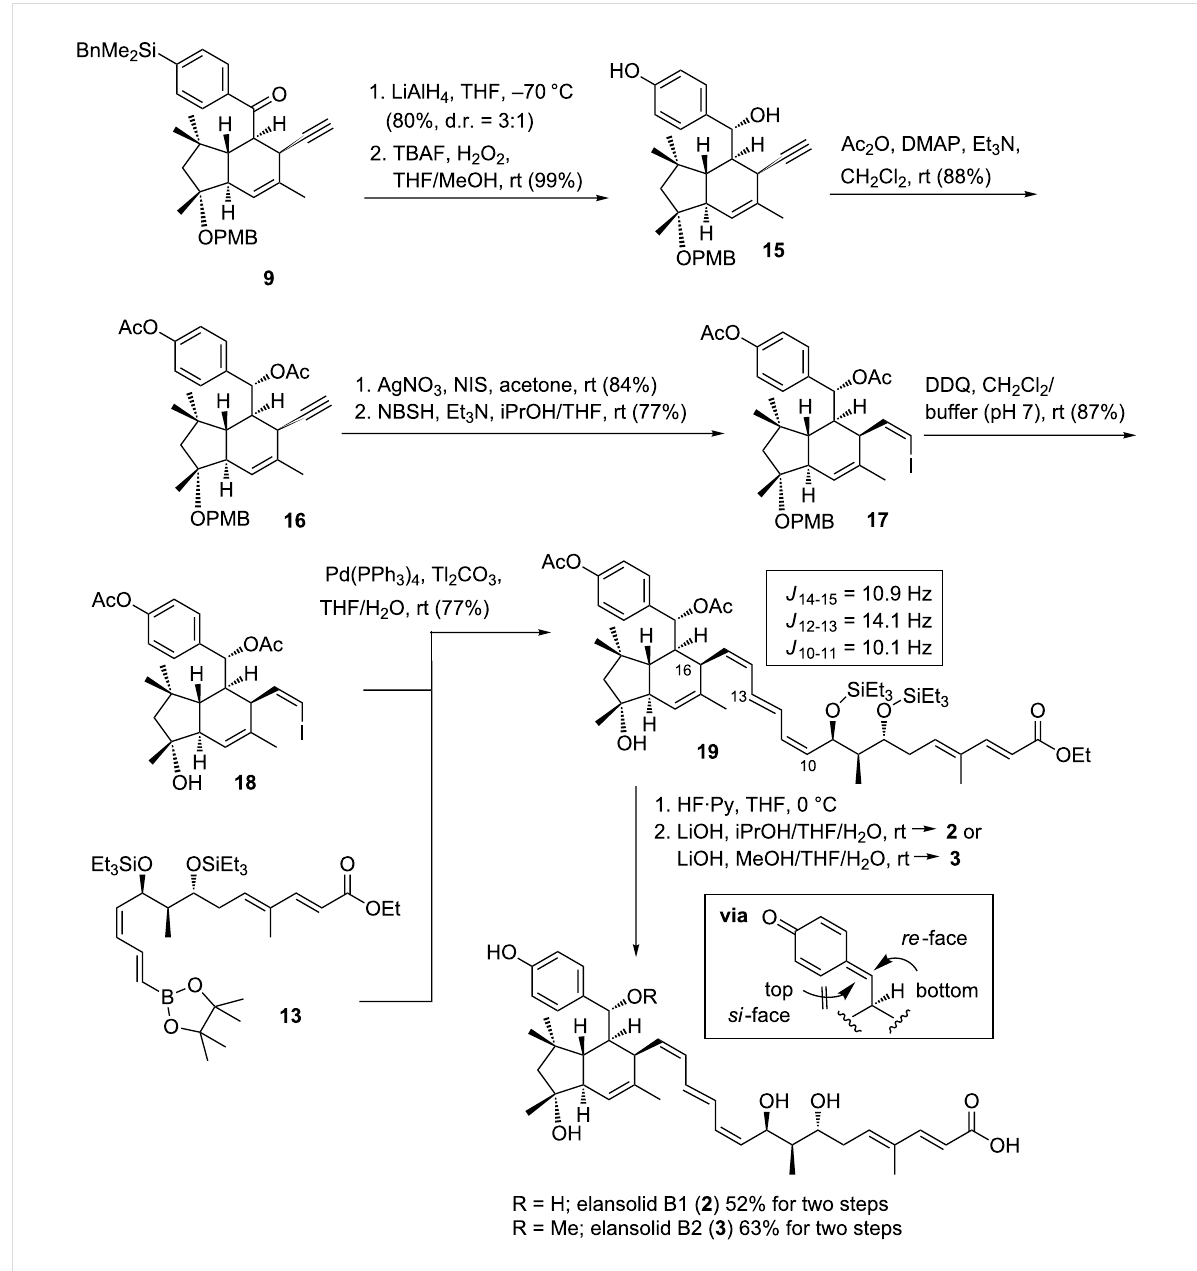
Scheme 3: Total synthesis of elansolids B1 ( 2 ) and B2 ( 3 ).